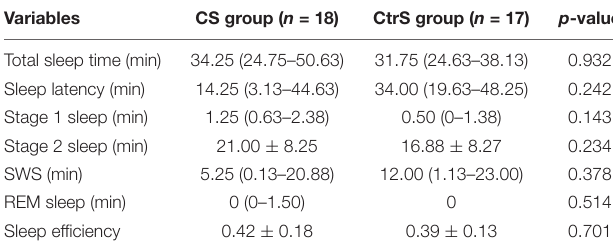
TABLE 2 | Sleep parameters in the CS and CtrS